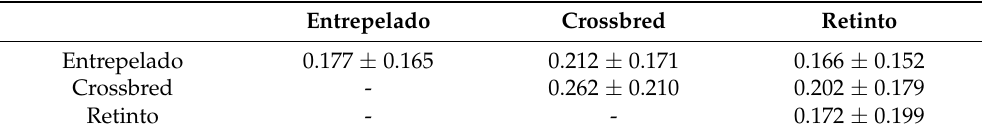
Table 3. REML estimates ± standard error (SE) of the dominance genotypic (co)variances for the total number born